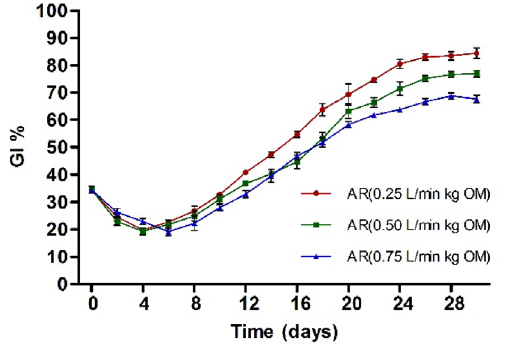
Fig. 6 Changes in the Germination index (GI%) of compost with three different aeration